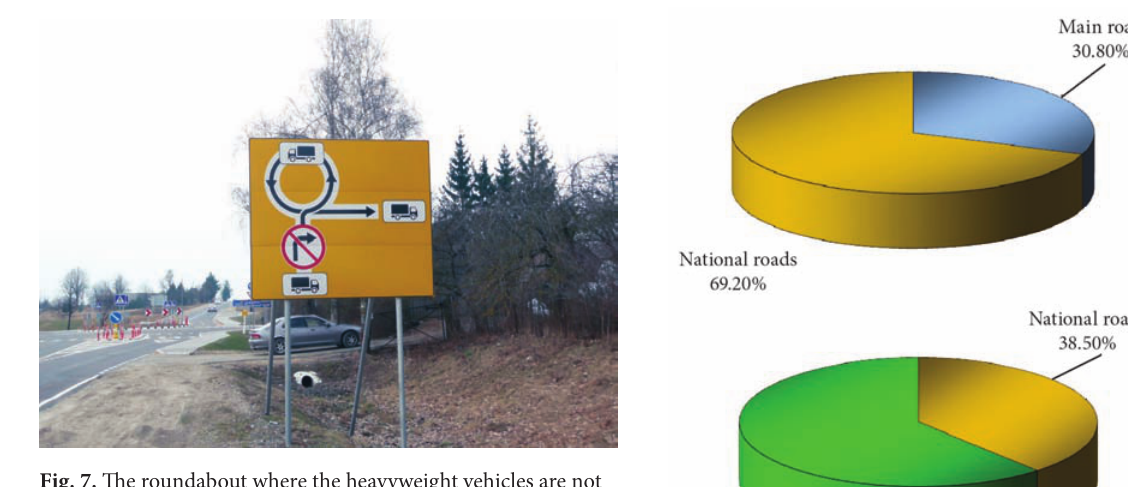
(Fig. 9) (Grīslis 2010; Juknevičiūtė-Žilinskienė 2010; Pet- kevičius et al. 2010).